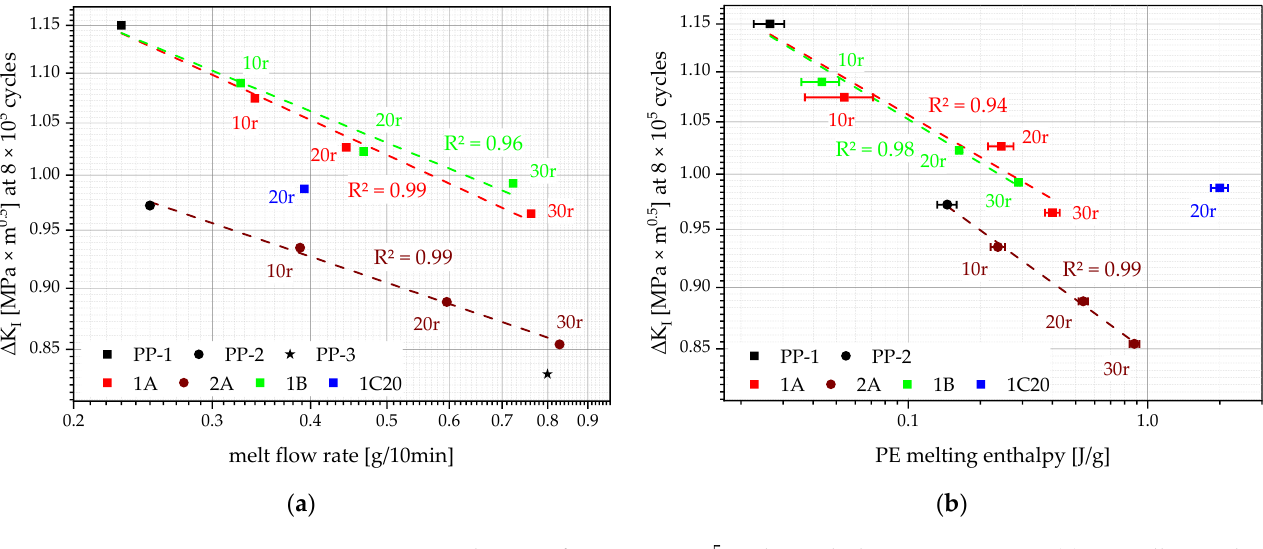
Figure 13. Correlations of ΔK I at 8 × 10 5 cycles with the respective MFR ( a ), as well as with the PE melting enthalpy ( b ) of the shown materials. The horizontal bars show the sample standard deviations. Linear approximations of the compounding series 1A, 2A, and 1B are plotted as dashed lines, and the respective R 2 values are shown in the matching colors.